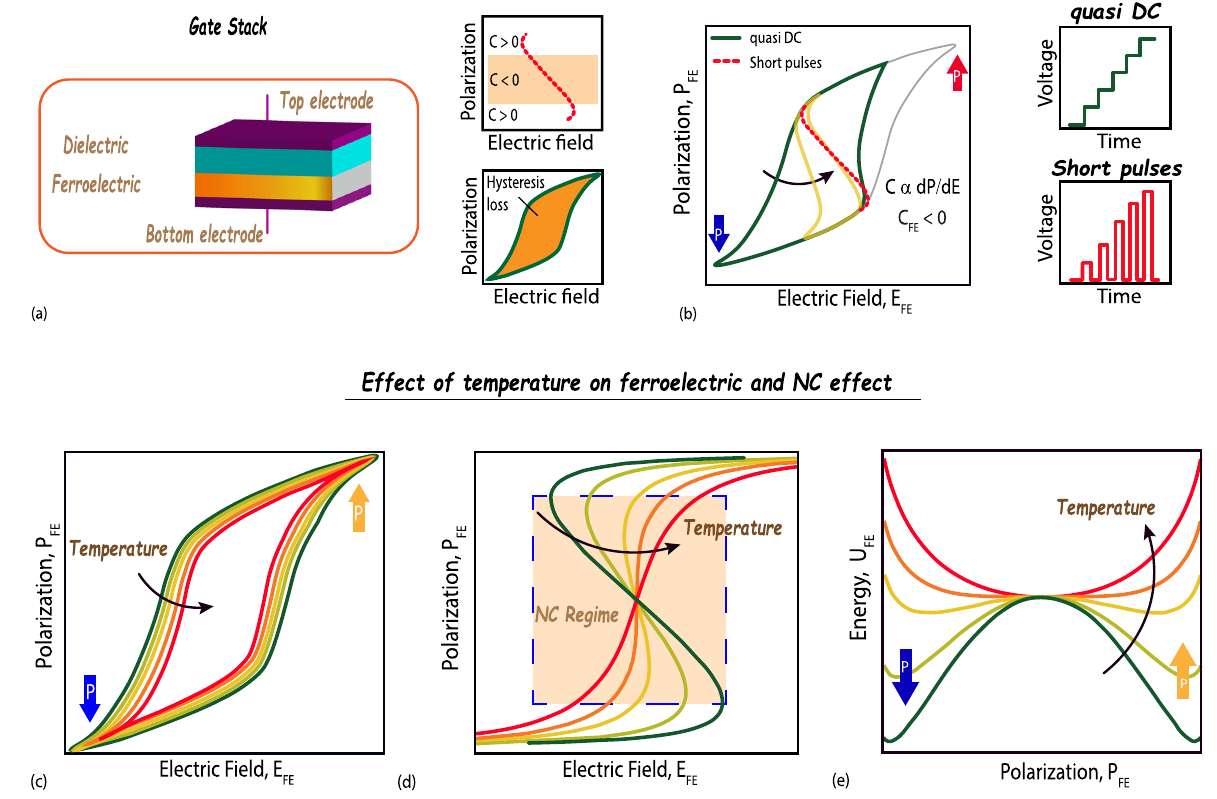
Fig. 1 Rationale and principle. a Schematic of the gate structure (left). The hysteretic behavior leads to an energy loss (right bottom) while the stable NC region without hysteresis improves the energy behavior of the gate stack (right top). b Qualitative comparison between quasi- DC and pulsed measurement techniques. c Temperature-dependent P − E loops. d , e The evolution trend of the NC effect and the potential energy U with increasing